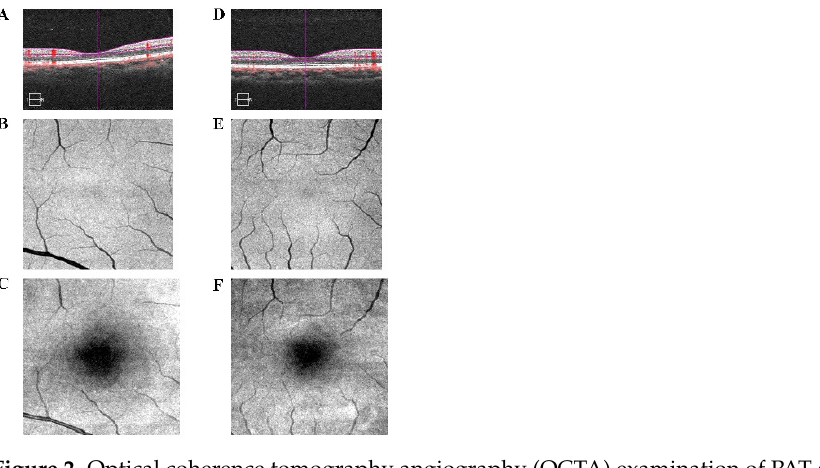
Figure 2. Optical coherence tomography angiography (OCTA) examination of PAT and HCs shows that PAT presented an increase in retinal thickness ( D ) and in fundus vessels ( E ), and a reduction in macular area ( F ) compared to HCs ( A – C